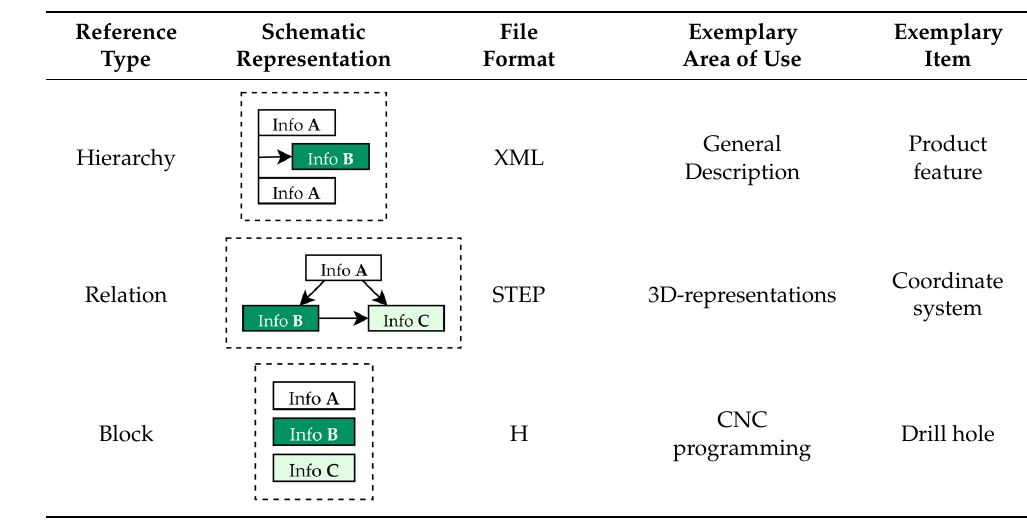
Table 2. Basic reference types in exchange files.